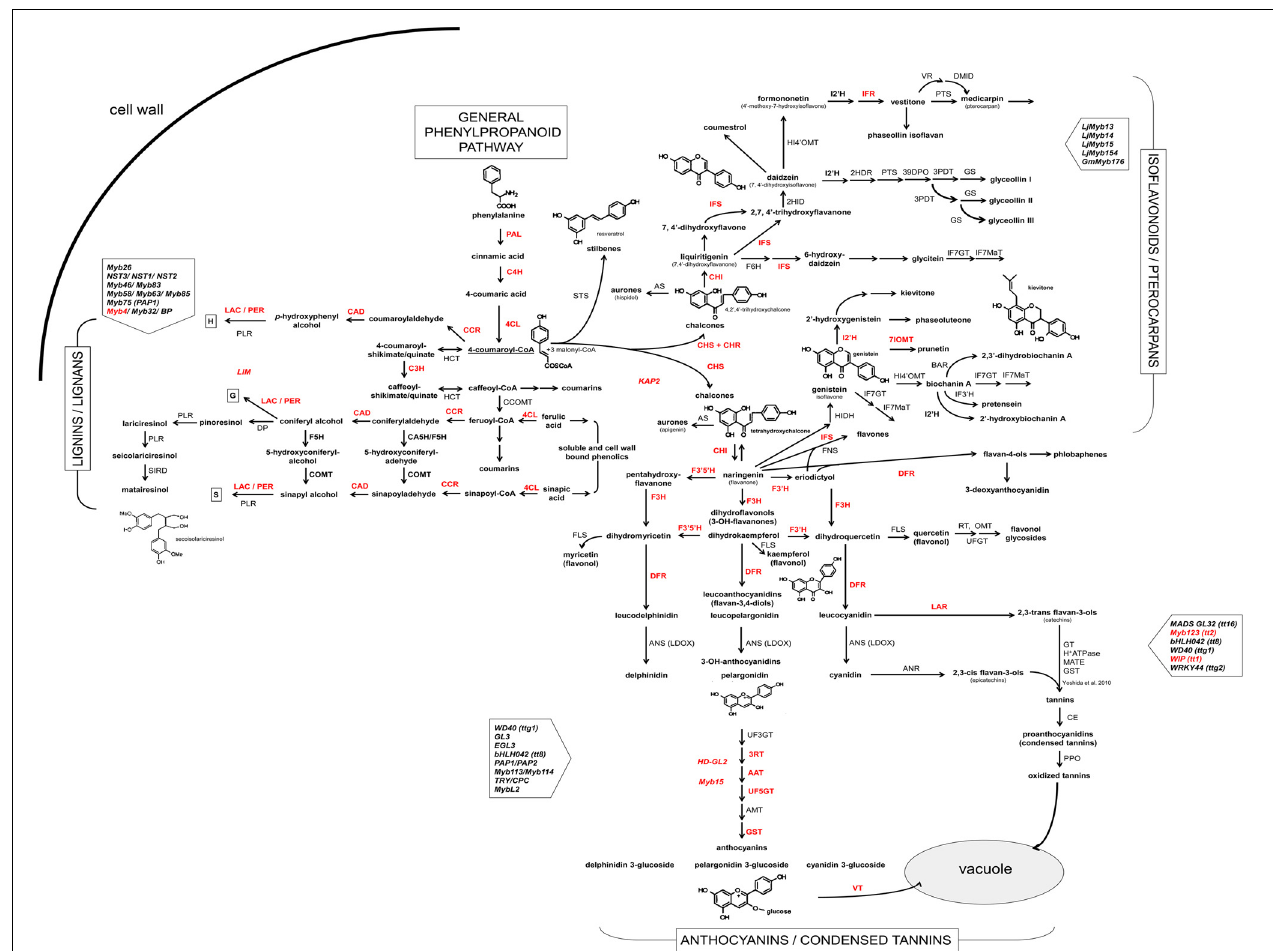
FIGURE 1 | Schemeofthephenylpropanoidpathwayincommonbeanand soybean. Enzymesand transcription factors of the phenylpropanoidpathway [basedon biochemicaland geneticstudiesof severalplant speciesand (KEGG Pathwaydatabase (http://www.genome.jp/kegg/pathway.html)]are presented in uppercaseletters: PAL, phenylalanineammonialyase (EC:4.3.1.24);C4H, cinnamate4-hydroxylase(EC:1.14.13.11);4CL,